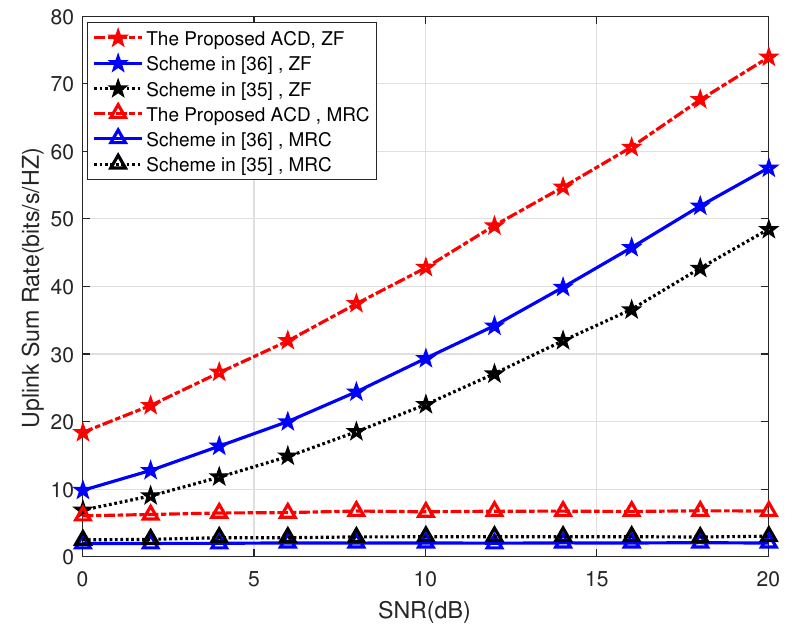
Figure 6. Uplink sum rate of the three schemes versus signal to noise ratio